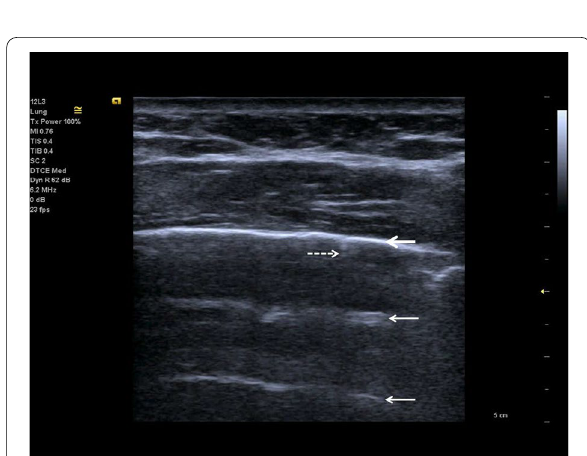
Fig. 7 Follow-up of an ICU patient with COVID-19 pneumonia after mechanical ventilation. An indirect sign of recovery is the appearance of A-lines (white arrows) through the recovery phase. No major pleural fragmentation (bold white arrow) is seen, but a mirror effect is visible (left white